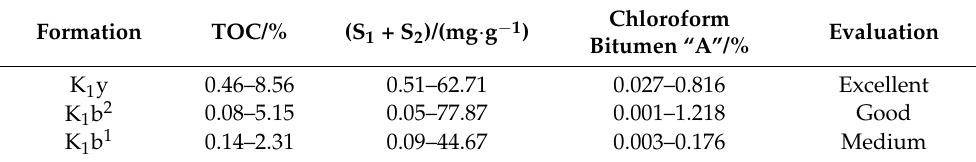
Table 1. Organic matter abundance in source rocks in the Hari sag.